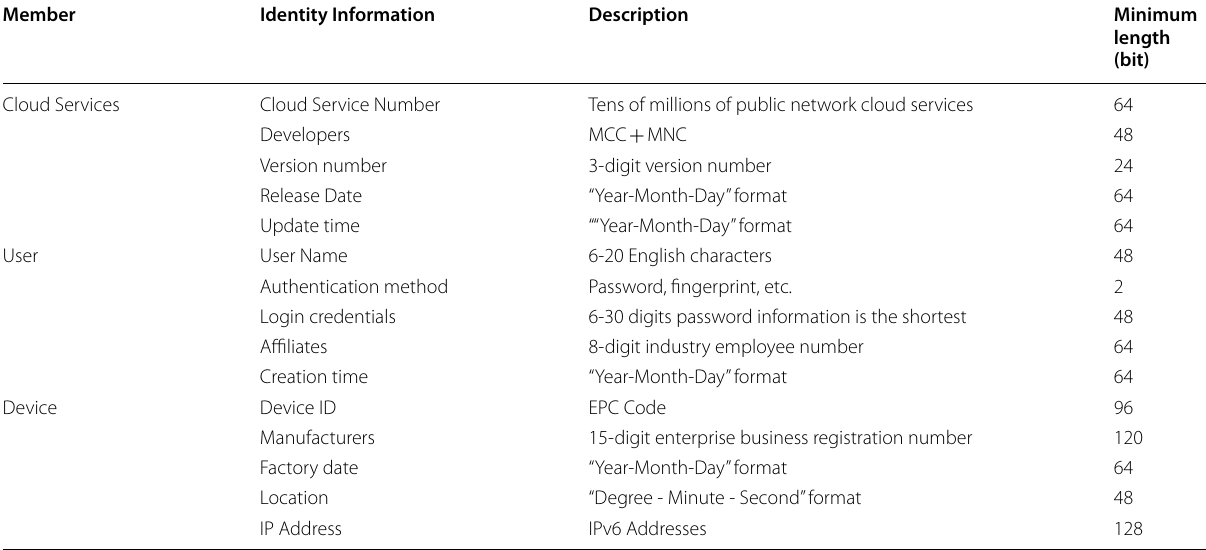
Table 1 Identity information